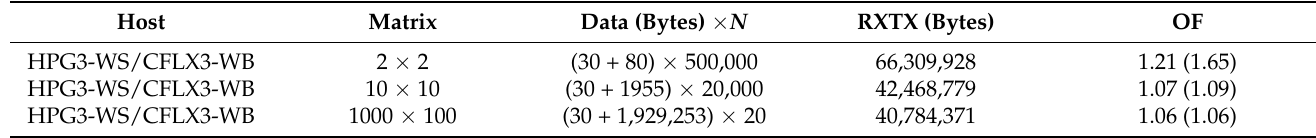
Table 1. Communication overhead for TCP-WebSocket channels by sending serialized matrix data (initialized with random numbers) between a shell worker and a WorkBook. The raw network RX-TX data load was measured by and collected from the LAN device. Overhead factor OF in parenthesis: pure